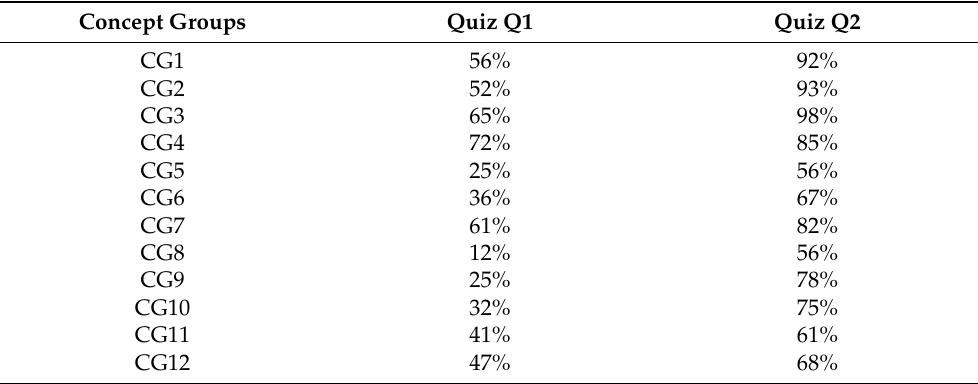
Table 3. Percentage of participants addressing the quizzes based on concept groups